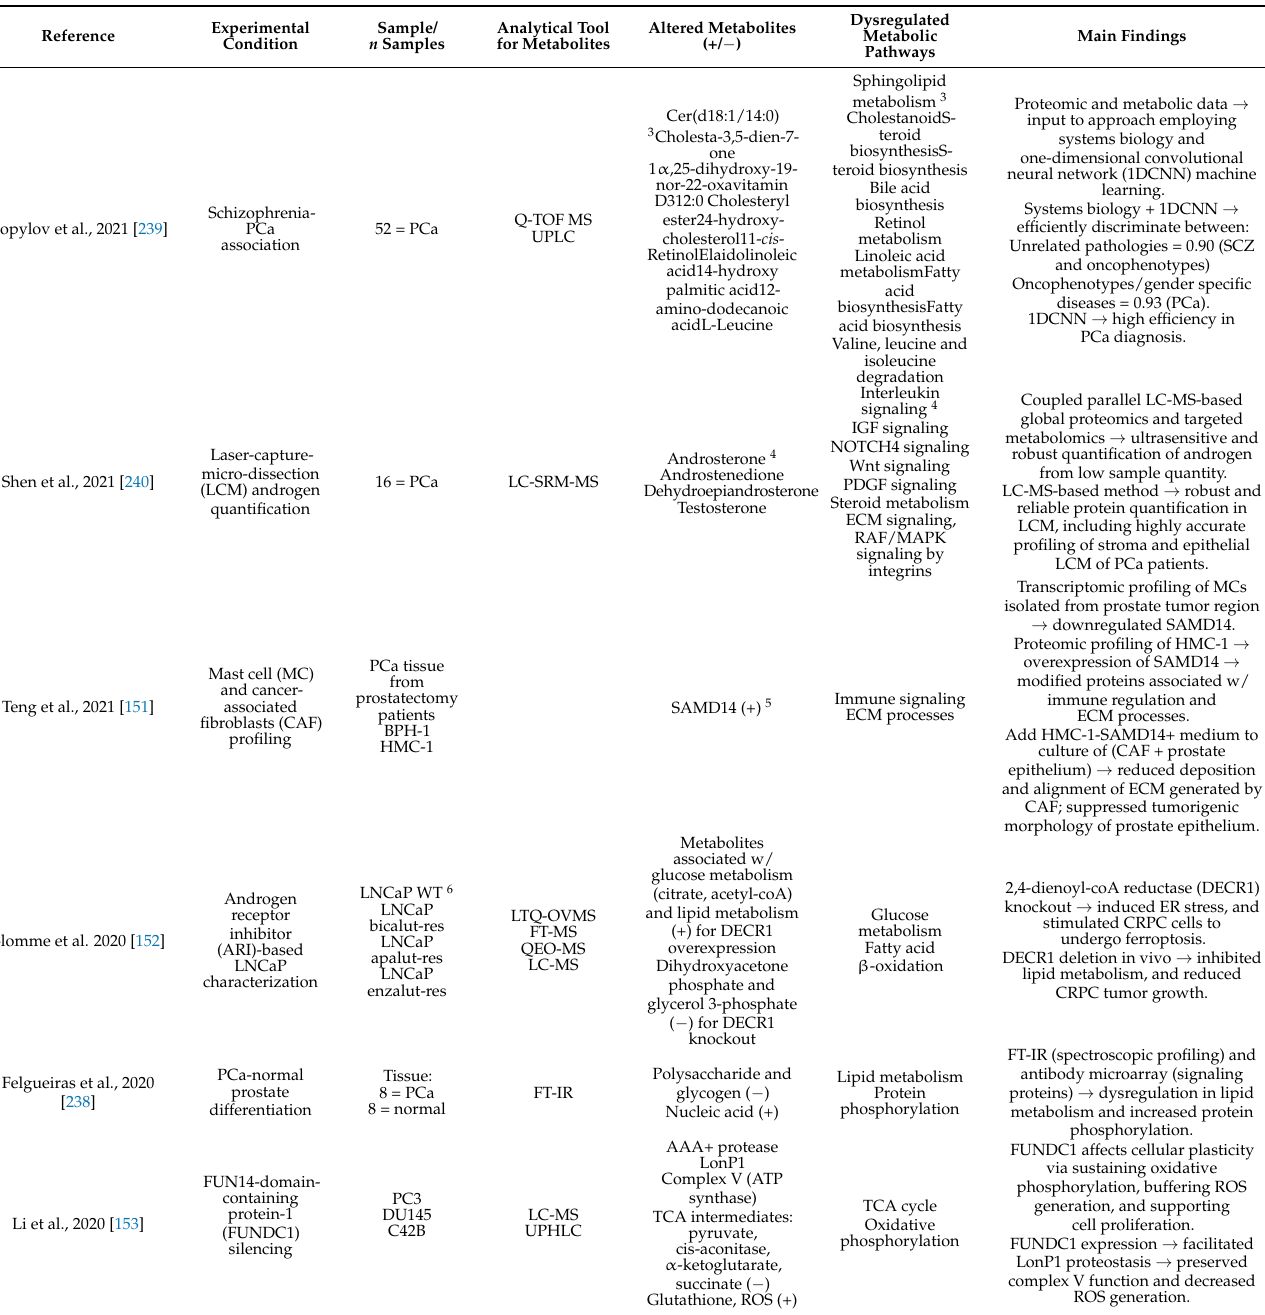
Table 3. Summary of proteomic–metabolomic integration studies for PCa within the last decade